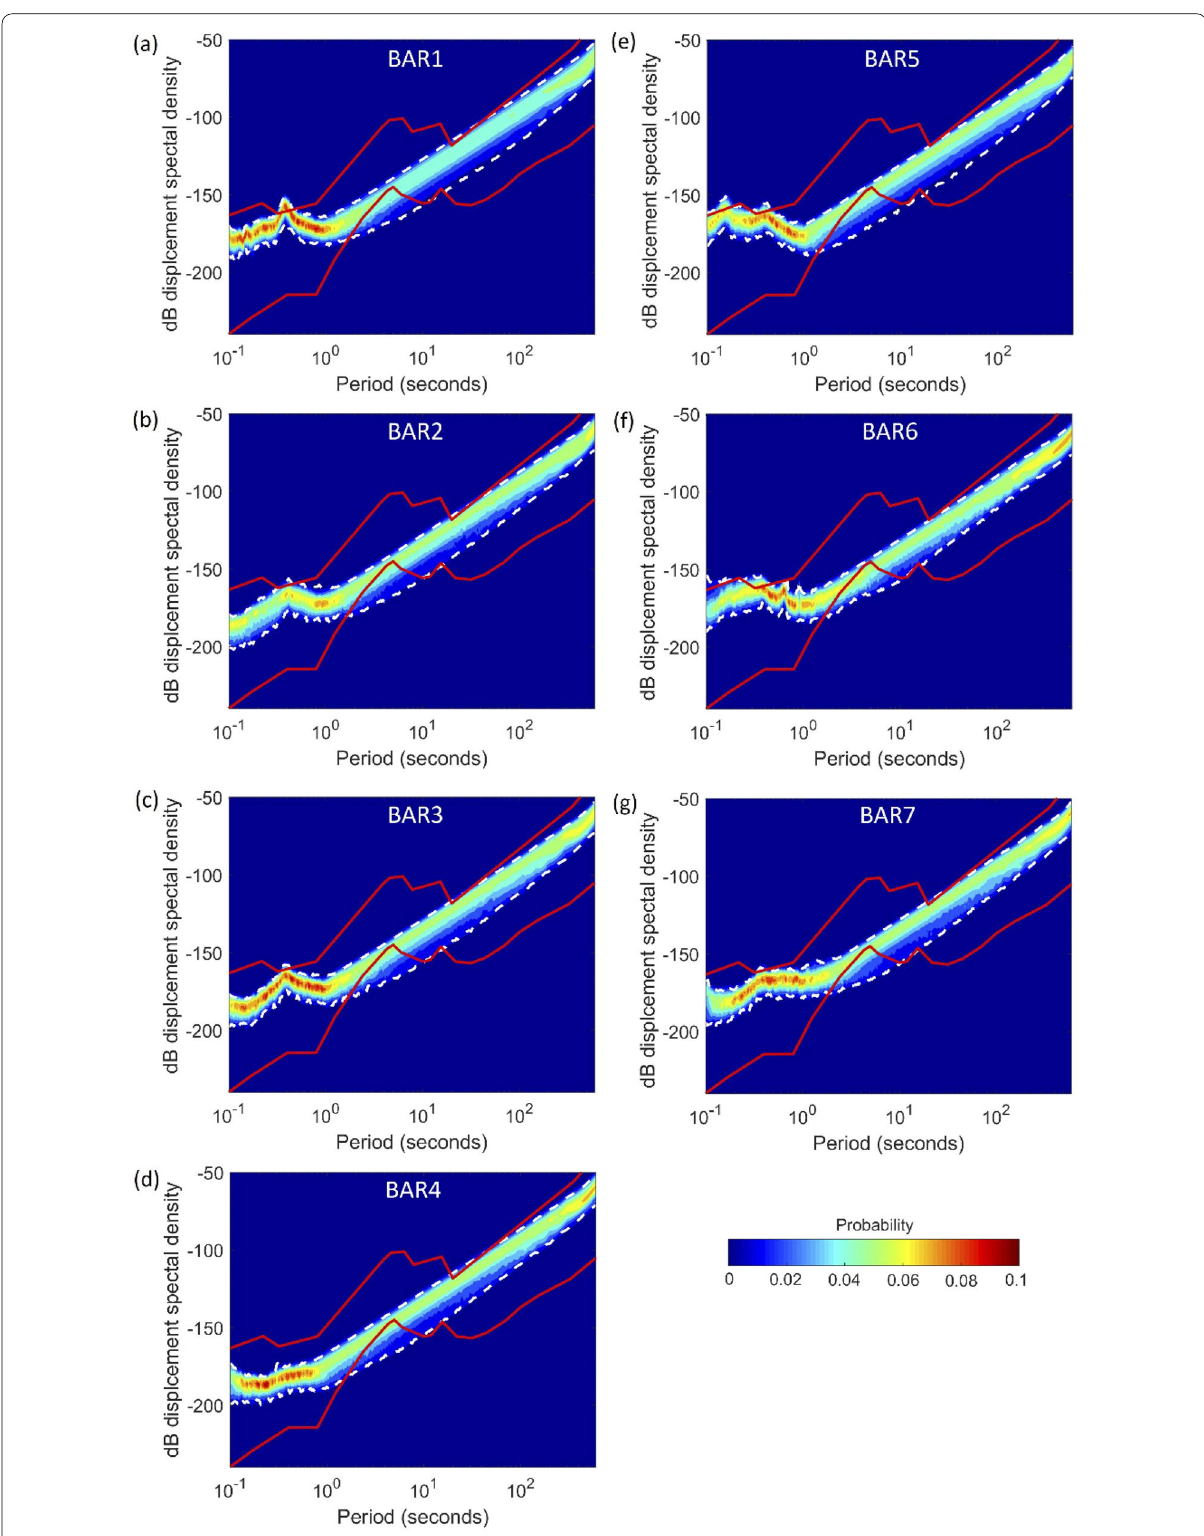
Fig. 3 PPSD for stations a BAR1, b BAR2, c BAR3, d BAR4, e BAR5, f BAR6, and g BAR7. Each plot was constructed using 9648 power spectral densities (PSDs) from August to November 2019. White dashed lines indicate the boundaries of 90 percent of the data distribution in each period. Red lines depict high- and low-noise models (Peterson